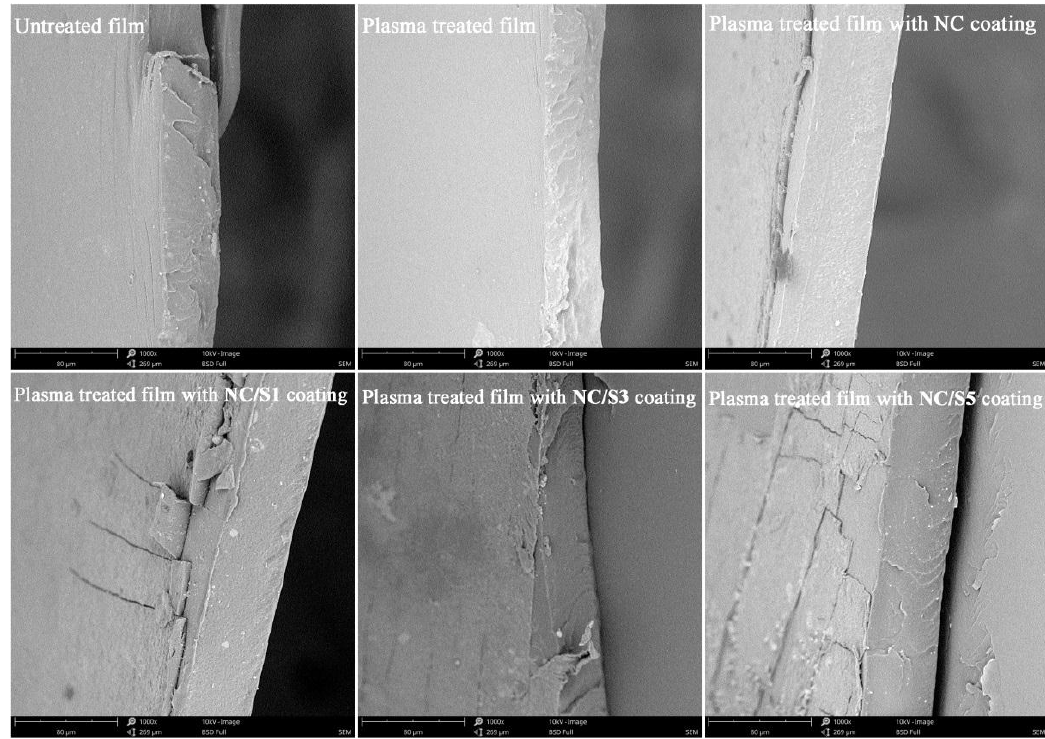
Figure 5. SEM images of BOPP/LDPE films under different surface process.